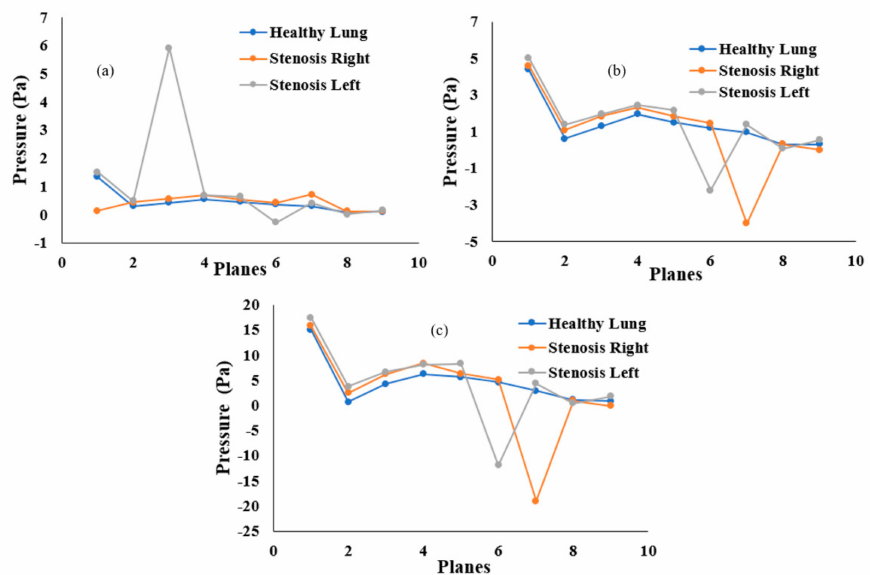
Figure 9. Pressure drop at di ff erent positions of the mouth–throat and upper airway for the healthy and stenosis lungs at ( a ) 7.5 lpm, ( b ) 15 lpm, and ( c ) 30 lpm.